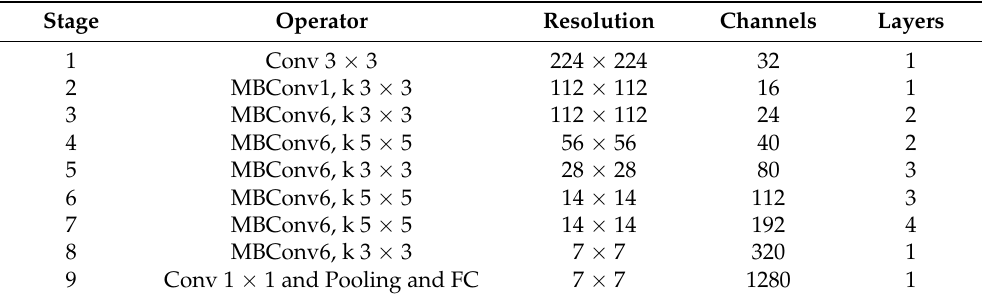
Table 3. EfficientNet-B0 network